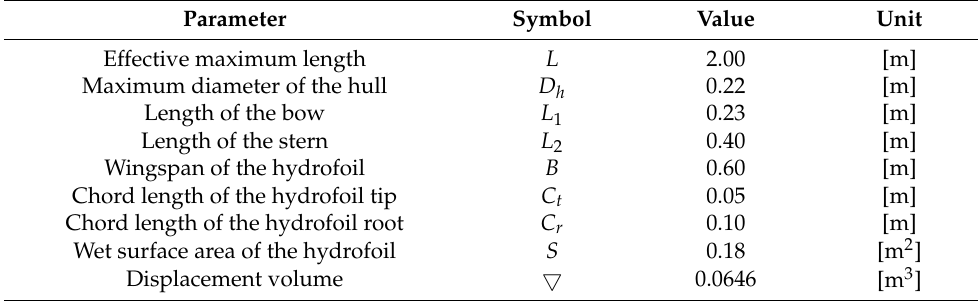
Figure 3. Numerical tank with the boundary conditions.